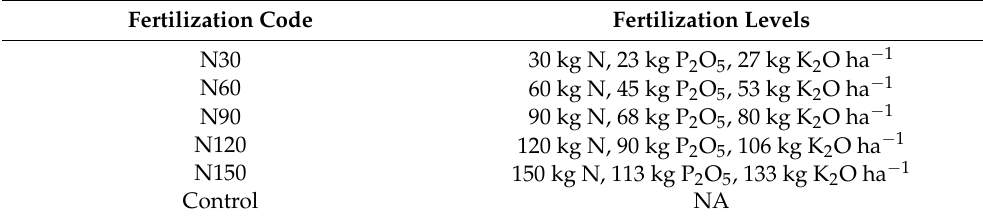
Table 1. Treatments of long-term experiment (1996–2008)